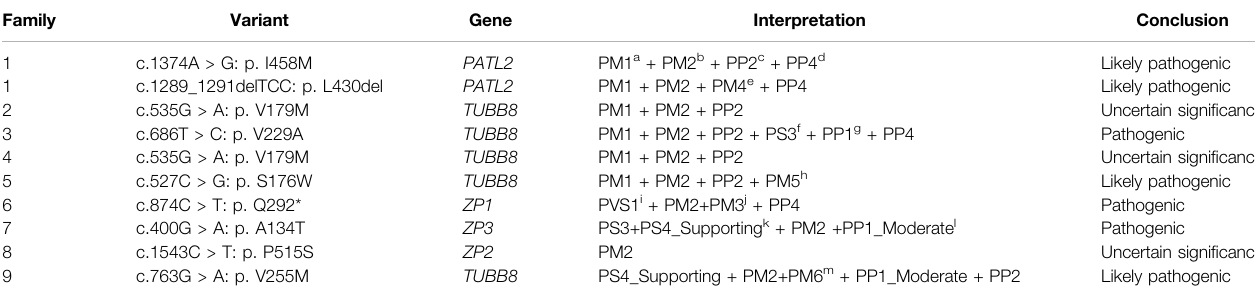
TABLE 2 | The evidence item description according to ACMG.